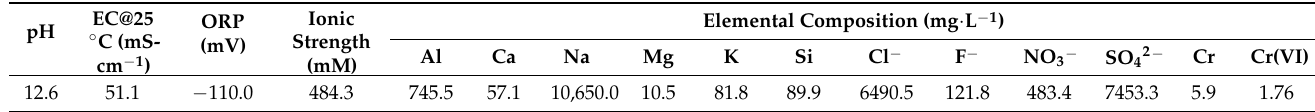
Table 2. Chemical properties of red-mud leachate.